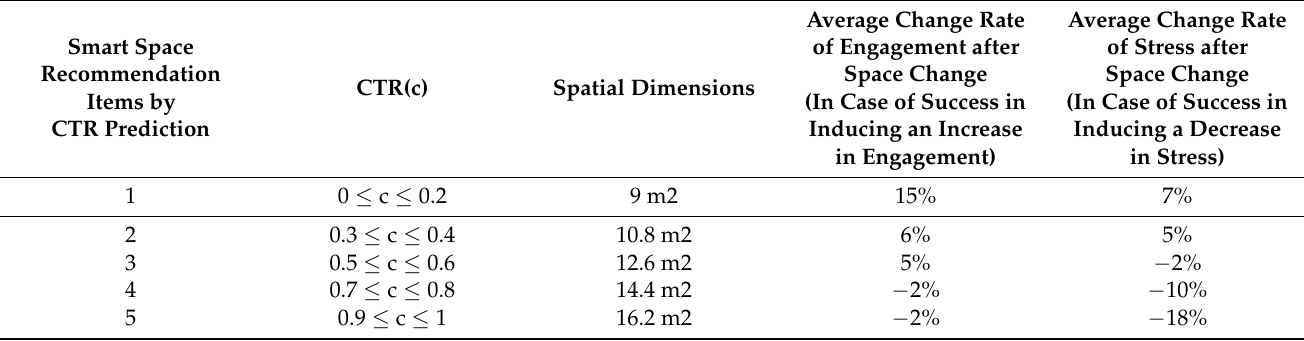
Table 2. Average rate of change upon success in increasing engagement and lowering stress after space change by AI